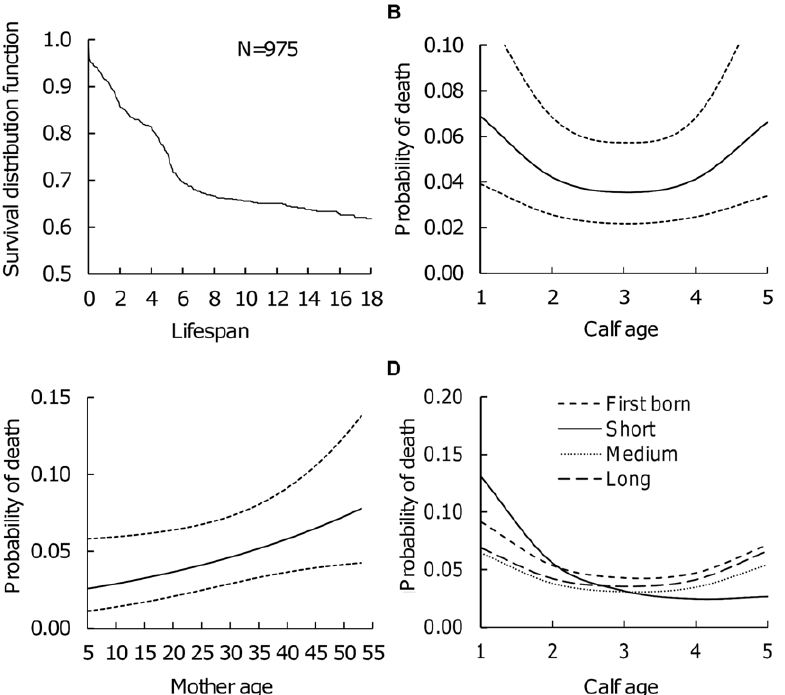
Figure 2. Overall survival distribution function of Asian elephants from birth to age 18 (A) and correlates of mortality of liveborn calves from birth to age of 5 (B–D) (Table 3). The mortality risk was highest during the first two years of calf life, and rose again between ages four and five (B). Calves born to older mothers had an increased probability of death irrespective of their own age (C) and short inter-birth interval put calves to higher risk of dying during their first two years of life (previous birth interval and calf age interaction, D). The sample size to which the discrete time survival analysis (B–D) was based was 975 calves with total of 4121 observations and correlated terms also included calf sex, birth order, birth cohort and repeated terms of the same mother and living area (mother id and mother area, see Methods and Table 3). Each year of calf age (1– 5) illustrates the probability of dying within the previous full year (B,D, see Methods). The classification of inter-birth interval to first born, short, medium and long was based on the distribution of the birth interval length in the population and to 25% and 75% quartiles (D, see Methods). Figures show predicted values and 95% confidence intervals (B,C) from the model.